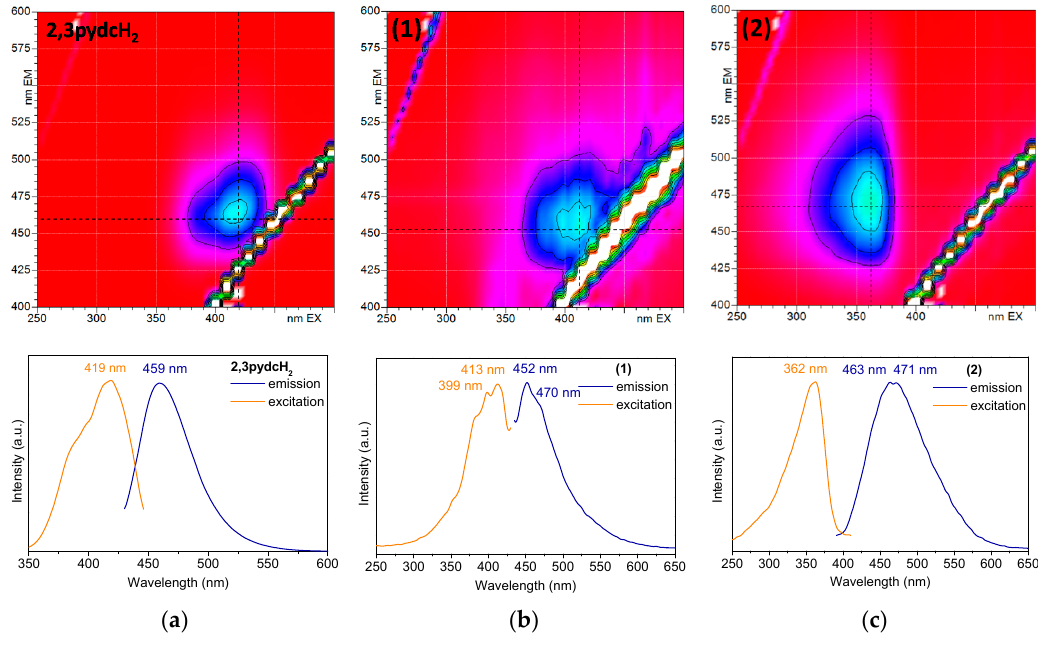
Figure 9. The solid-state 3D (top) and 2D (bottom) photoluminescence spectra of: ( a ) 2,3pydcH 2 , ( b ) compound 1 and ( c ) compound 2 .